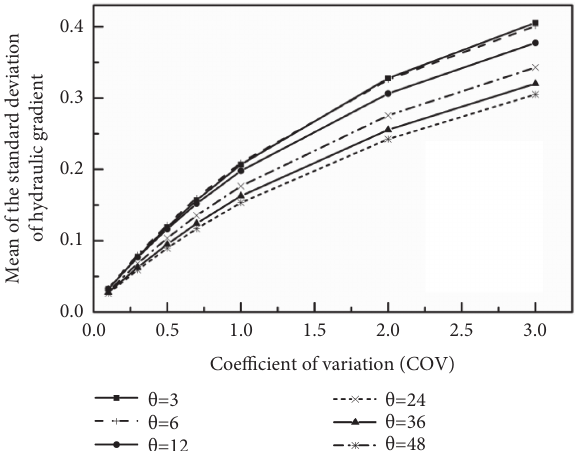
Figure 10: Mean of standard deviation of hydraulic gradient versus COV of hydraulic